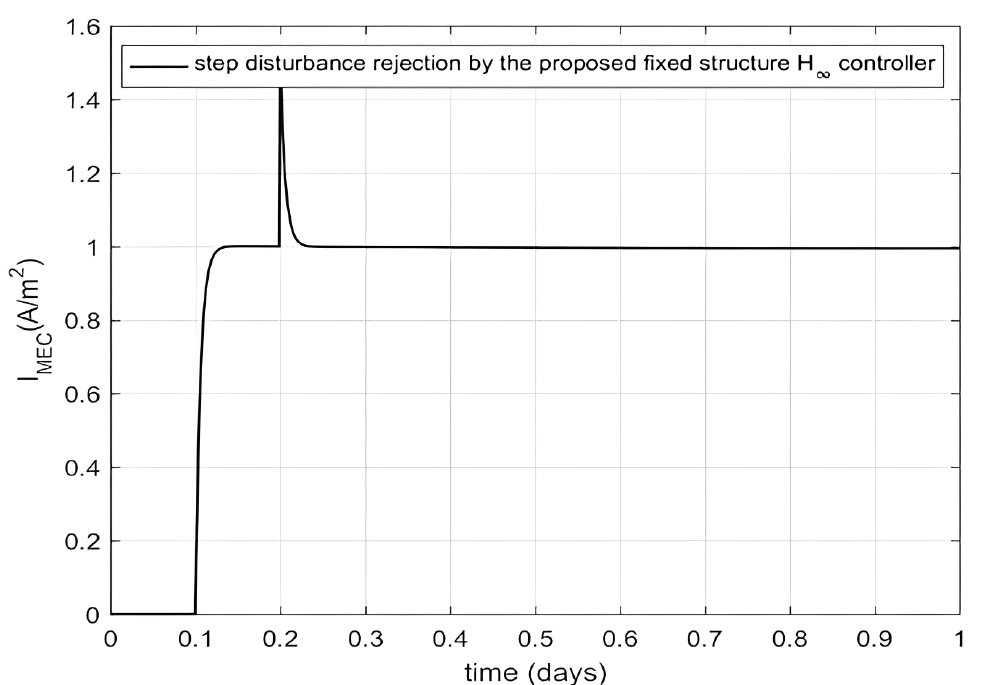
Figure 12. Plots of randomly generated external noise (first panel) and step tracking of the fixed structure H ∞ controller in presence of external noise (second panel).